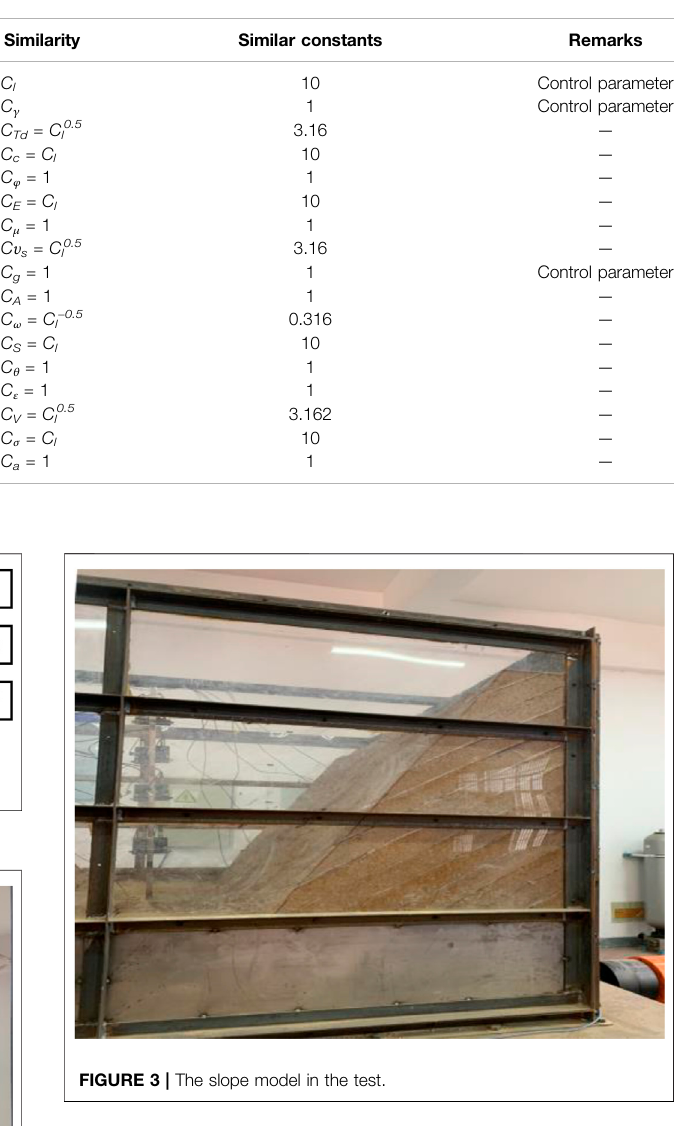
TABLE 1 | Similar constants of shaking table test.